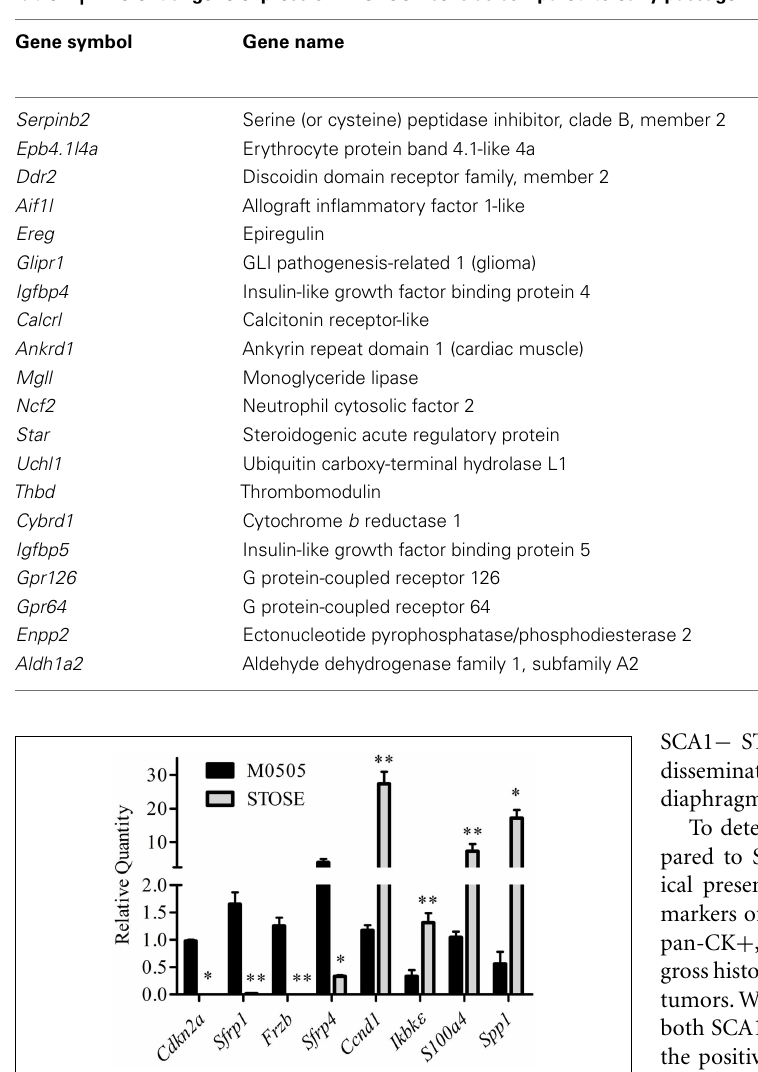
Table 2 | Differential gene expression in STOSE cells as compared to early passage M0505 cells.